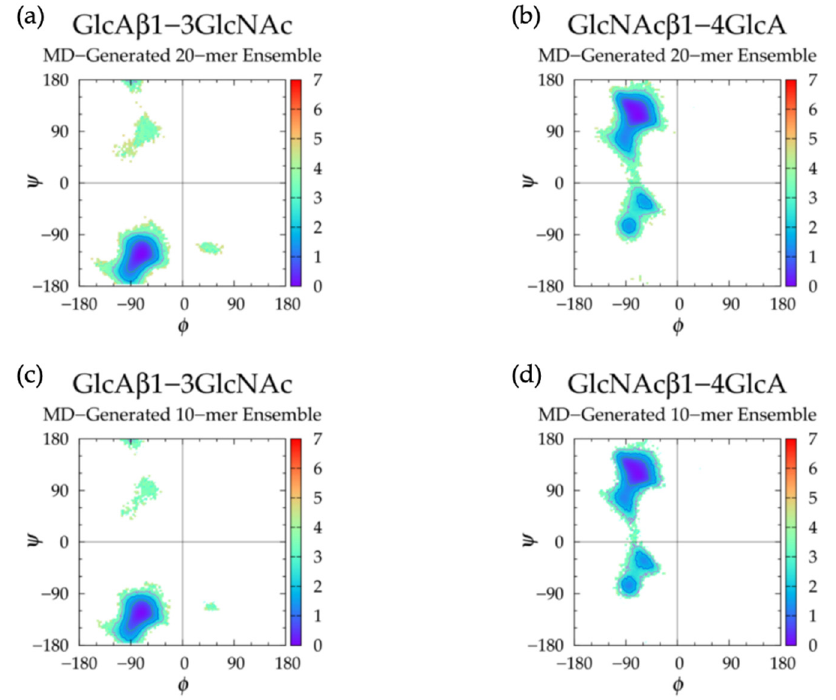
Figure 5. ∆ G ( φ , ψ ) in the MD-generated hyaluronan ensembles for aggregated GlcA β 1-3GlcNAc and GlcNAc β 1-4GlcA glycosidic linkage data in the ( a , b ) 20-mer and ( c , d ) 10-mer, respectively; contour lines every 1 kcal / mol. Table 2. Hyaluronan Glycosidic Linkage Dihedrals ( φ , ψ ) 1 and Free Energy ( ∆ G ( φ , ψ ) kcal / mol) Minima. MD-Generated 20-mer